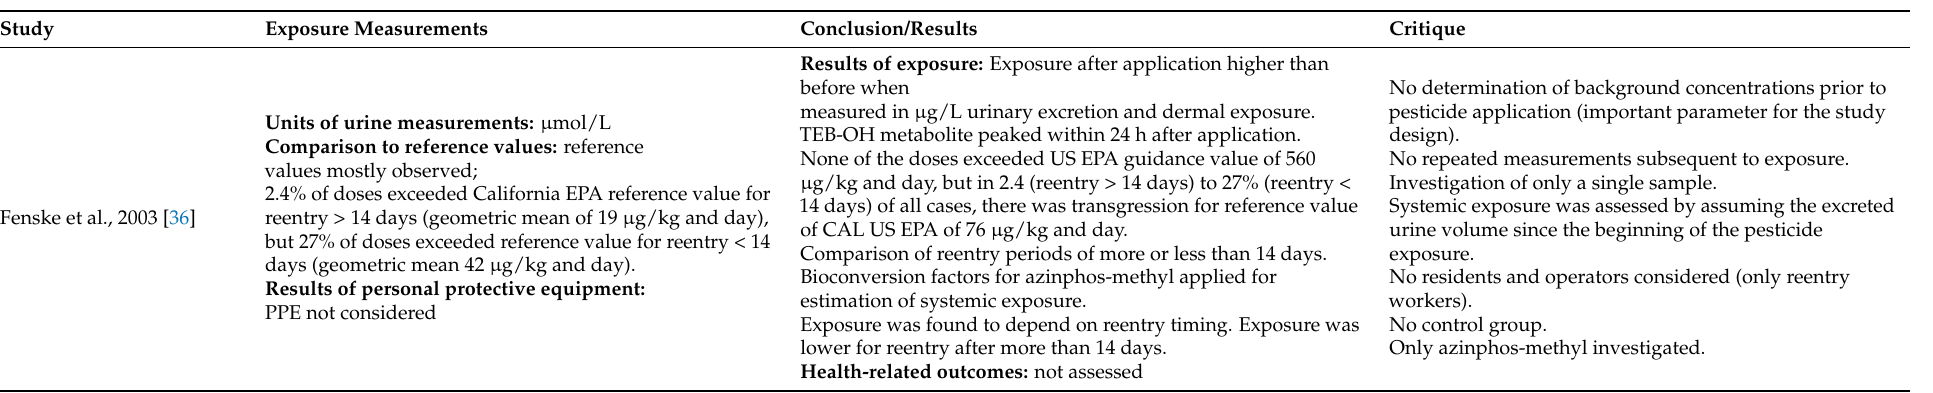
Table 3. Results of studies on fruit trees as target